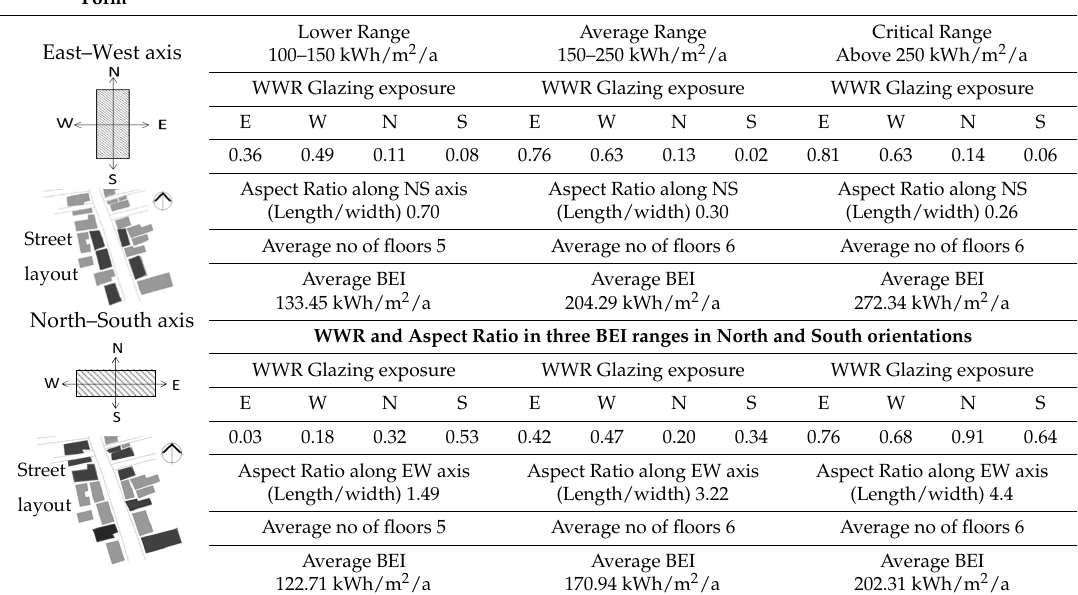
Table 6. Summative results of the nexus between aspect ratios, BEIs, WWRs, and orientations of buildings on the North–South and East–West axes.